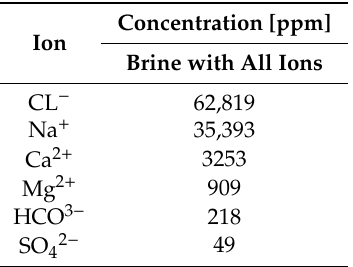
Table 1. Ion content in